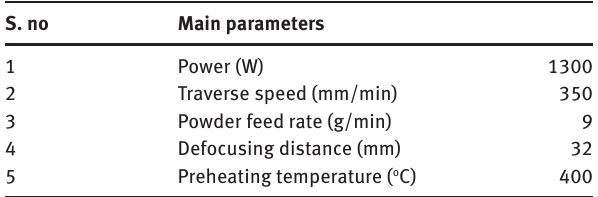
Table 10: Optimized laser hardfacing parameters. S. no